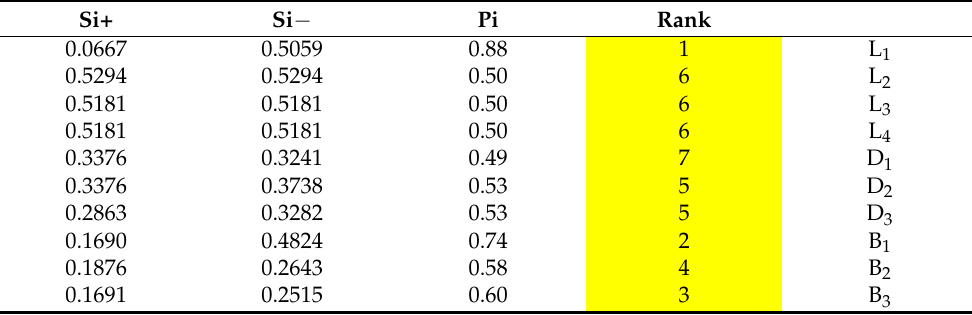
Table 9. Euclidean distance from the ideal worst and